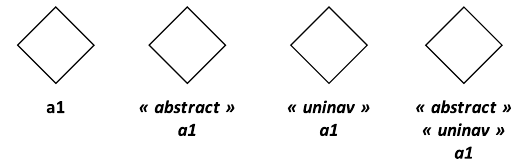
Fig. 8. Graphical representation of an association ( Assoc